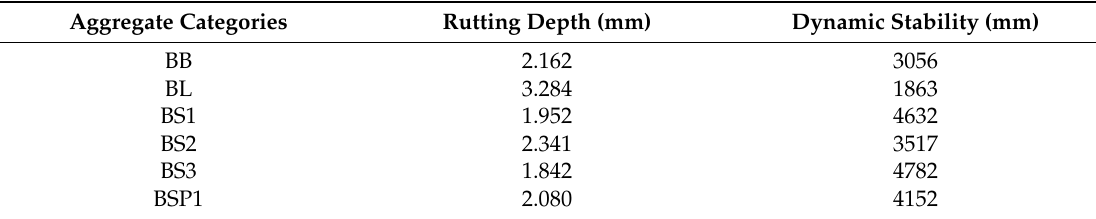
Table 13. Rutting text results with different coarse aggregates.